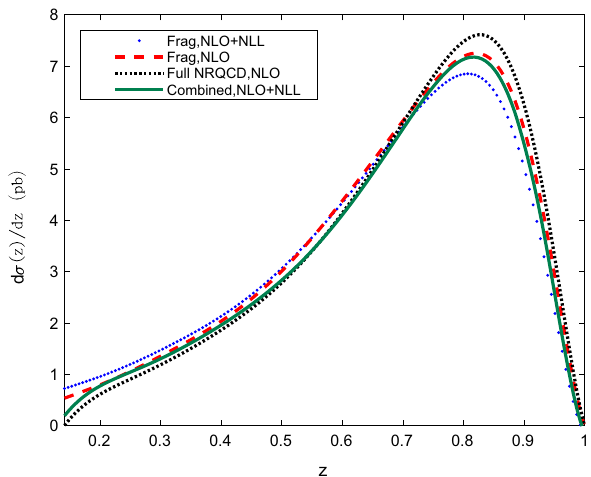
Fig. 6 The differential cross sections d σ/ dz for the production of the B ∗ c meson at the Z pole under different approaches